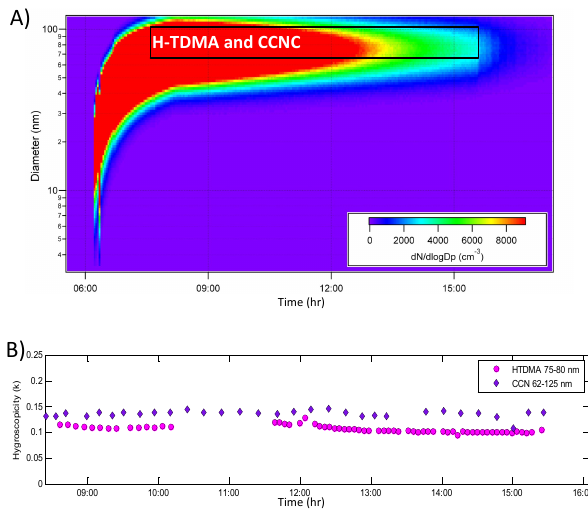
Fig. 2. (a) Evolution of the particle size distribution in the CLOUD chamber in the presence of sulphuric acid and pinanediol and UVS (Run B, Table 1). (b) Hygroscopicities measured by the H-TDMA and the CCNC.